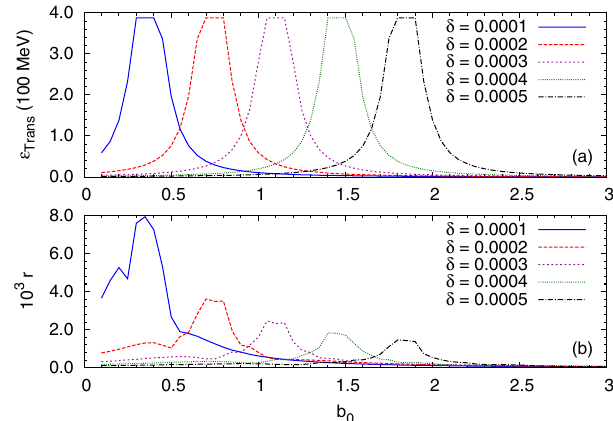
FIG. 7. Temporal evolution of the transverse kinetic energy for various values of applied magnetic fields with detuned phase modulation factor of